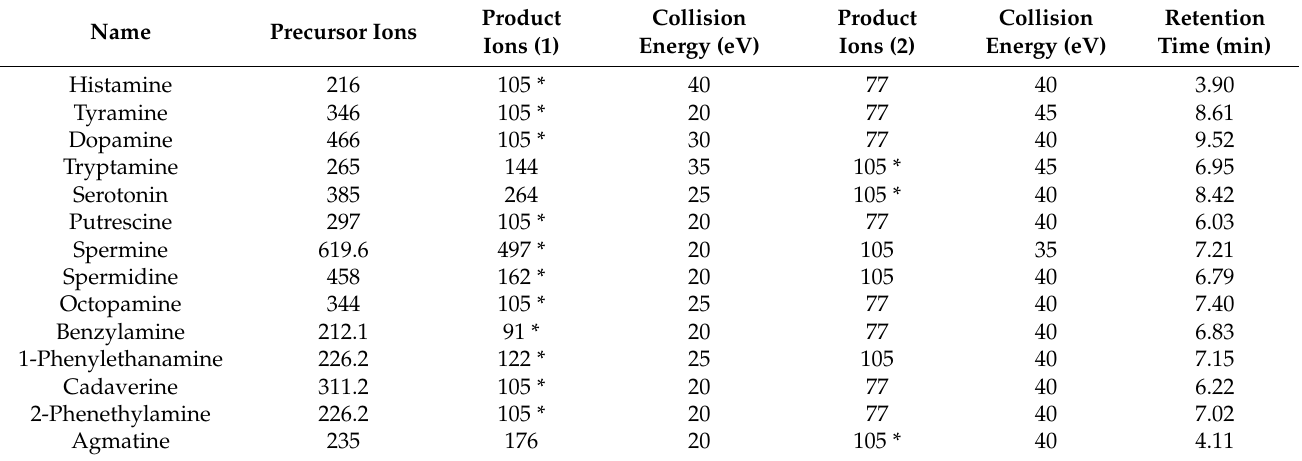
Table 1. MRM settings of the biogenic amine